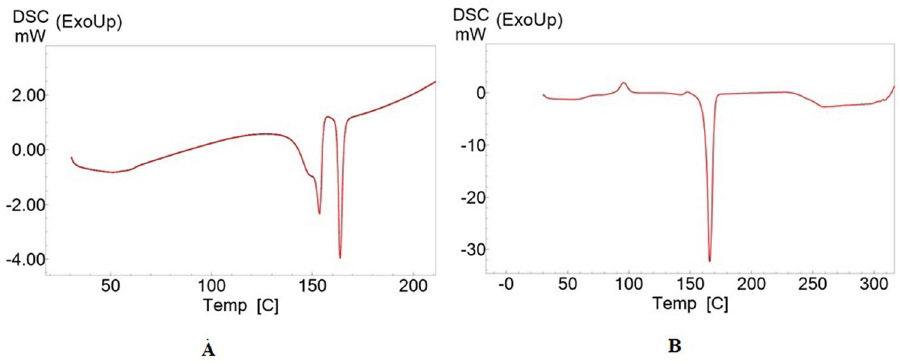
Figure 9. Differential Scanning Calorimetry analysis. ( A ) Thermogram of CCNP. ( B ) Thermogram of mAbCCNP.